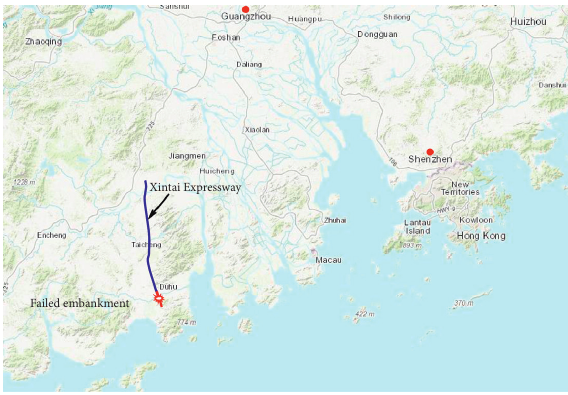
Figure 1: Location of failed